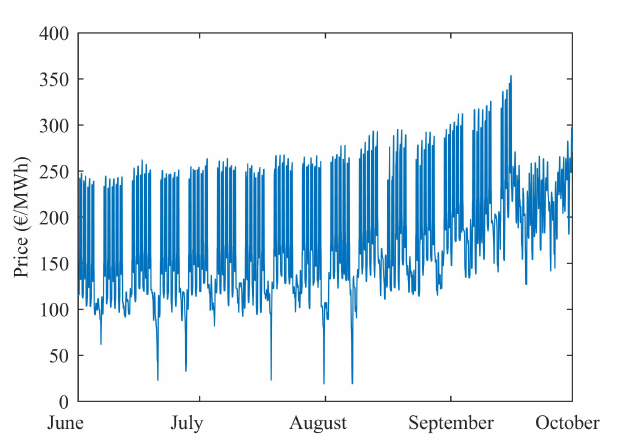
Figure 10. Hourly electricity prices during the period June–September 2021 with the tariff TD2.0.